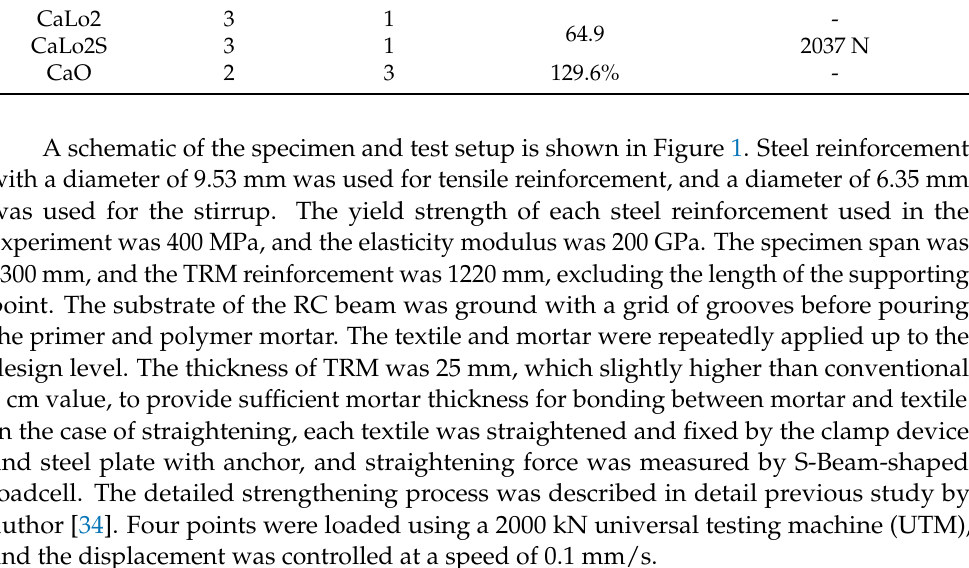
Table 4. Detailed specification of TRM beam.